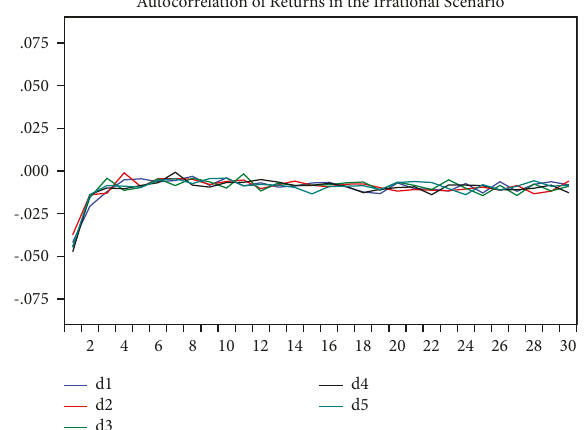
Figure 2: Autocorrelation of returns in the irrational scenario. The autocorrelation of returns in the irrational scenario is shown in this figure. The parameters from Zhu et al. [35] and Amilon [82] are implemented in the simulations. d is the strength regarding the behavioral hesitation and decision rigidity of the anxious agent. The length of the lag ranges from 1 to